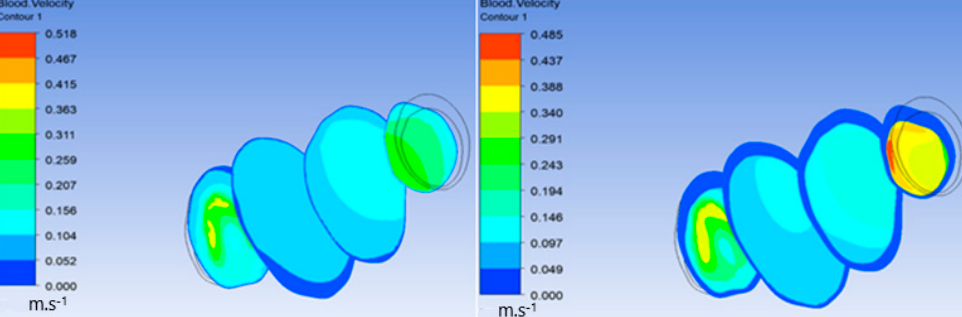
Figure 9. Decrease in velocity in the ILT region.